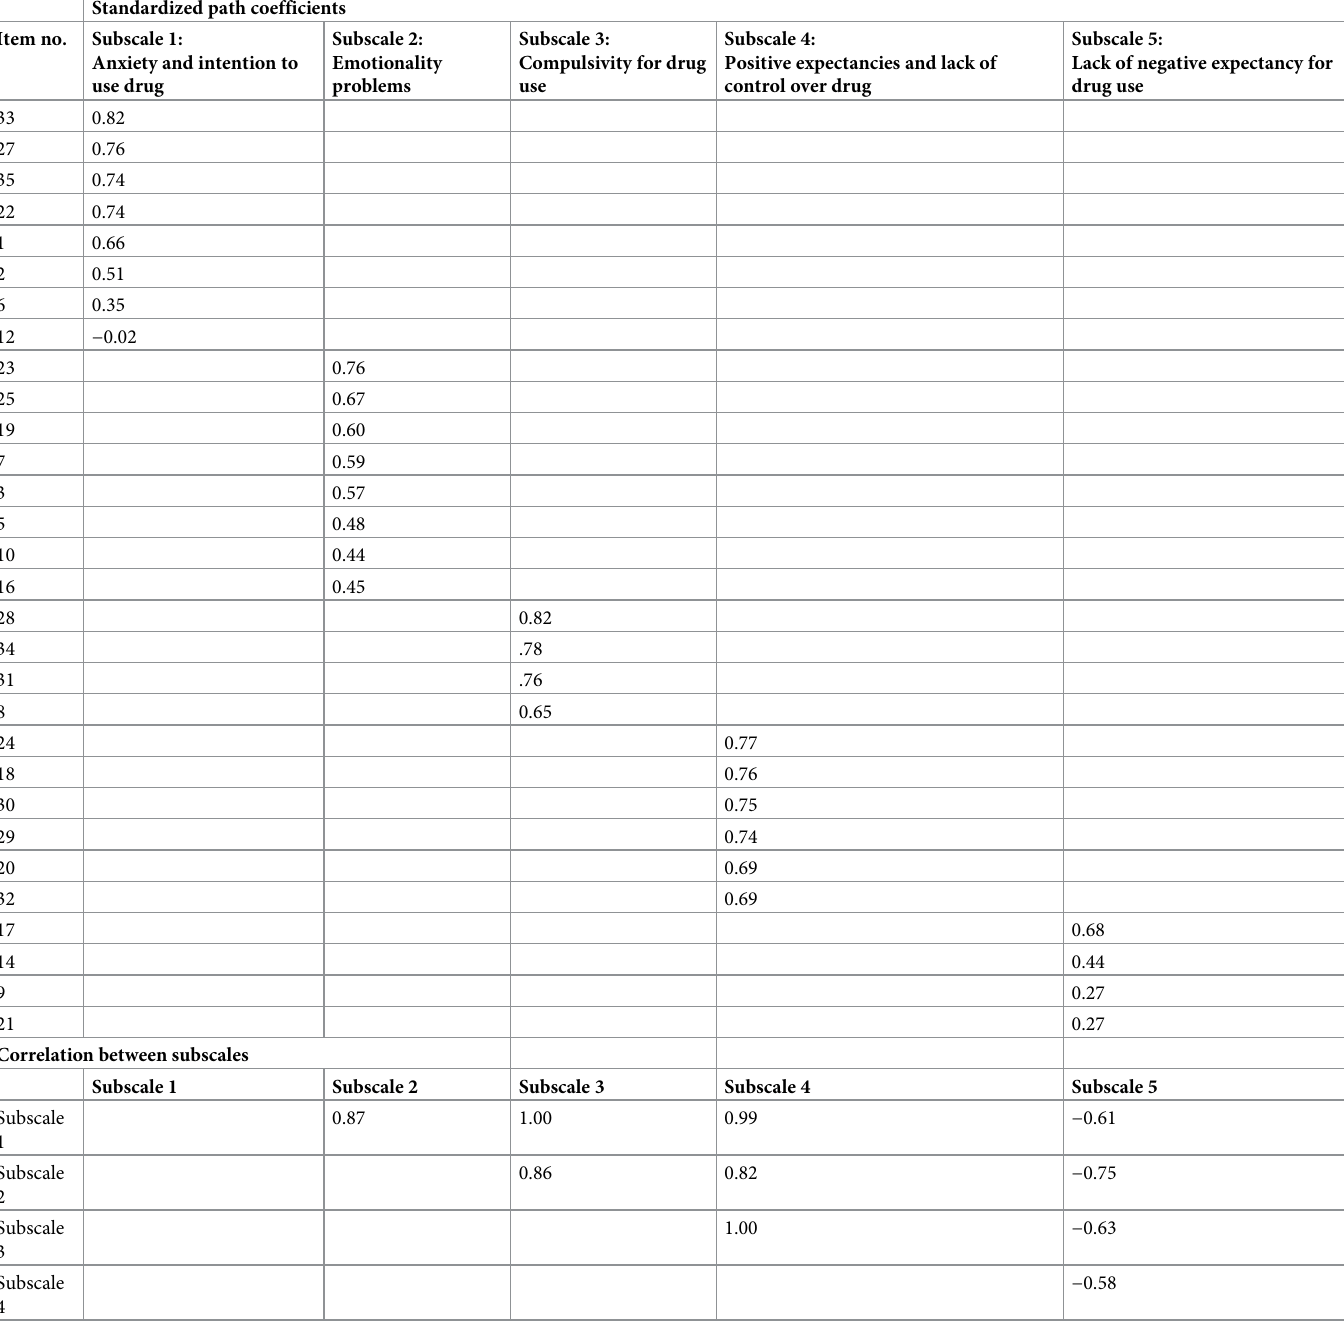
Table 5. Confirmatory analysis and model fit for the